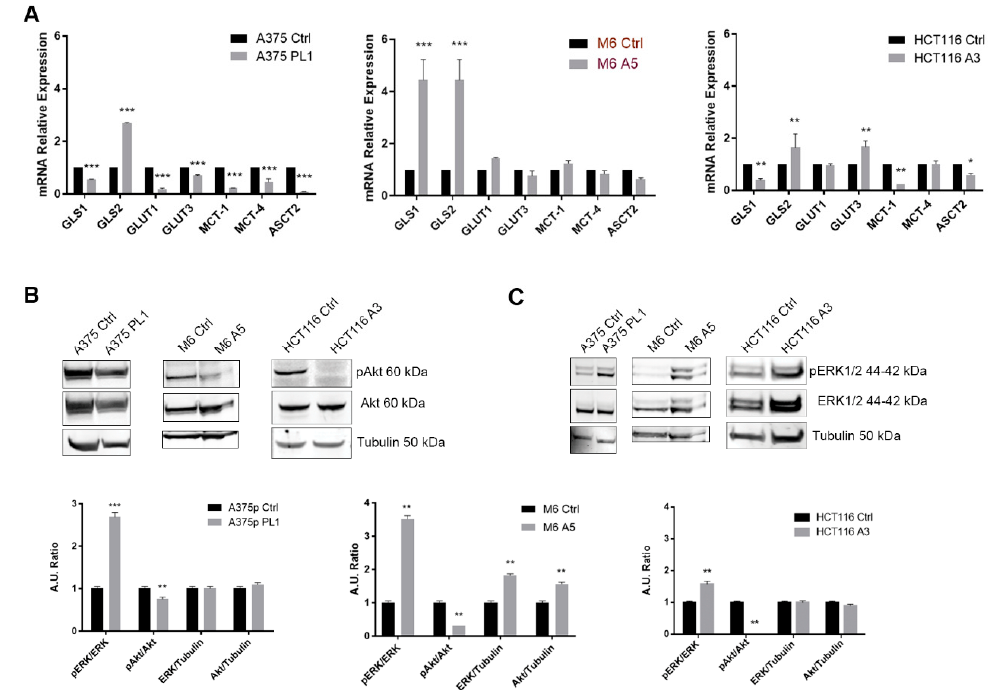
Figure 5. ( A ) Total RNA isolated was subjected to qPCR analysis of several of the main